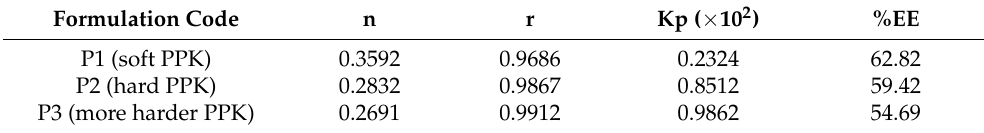
Table 1. In vitro release parameters and encapsulation efficiency values of various PPK hydrogels. Formulation